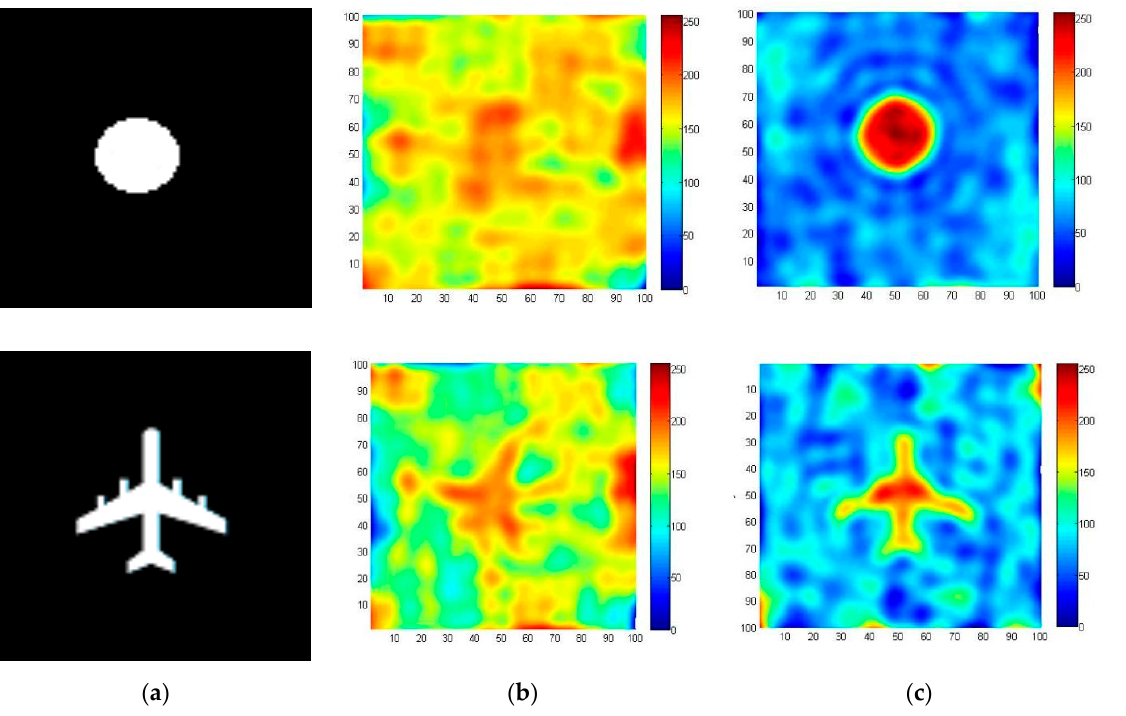
Figure 6. Simulation experiments of different objects. ( a ) Shows the simulated objects, ( b ) shows the results of the system error, and ( c ) is the result after error correction.